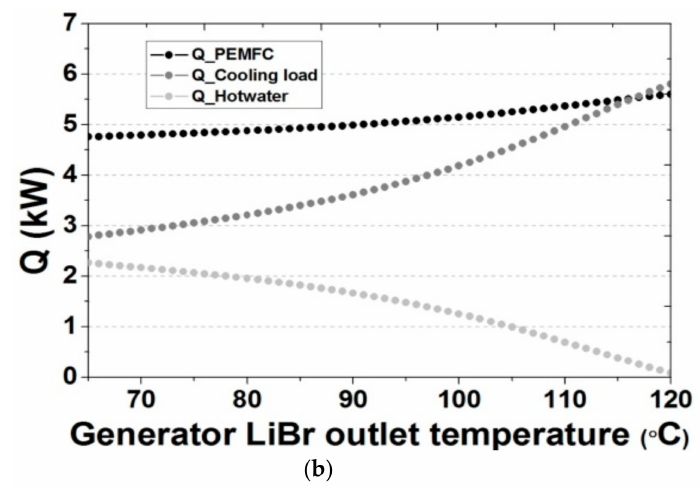
Figure 8. Comparison of stack heating value, cooling and hot water (heating) load according to LiBr solution temperature at the outlet of the generator of absorption cooling system. ( a ) Absorption cooling capacity: 2.0 kW; ( b ) Absorption cooling capacity: 2.5 kW.